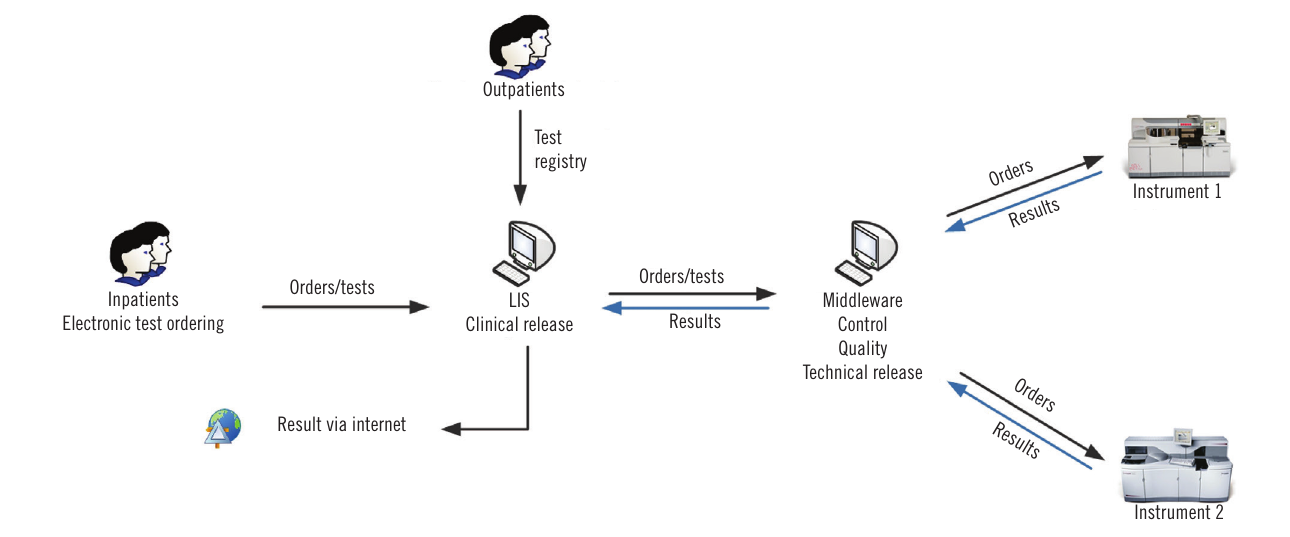
figurE 1 − Flow of test conduction at the core laboratory of HC/UFMG HC/UFMG: Hospital das Clínicas da Universidade Federal de Minas Gerais; LIS: laboratory information